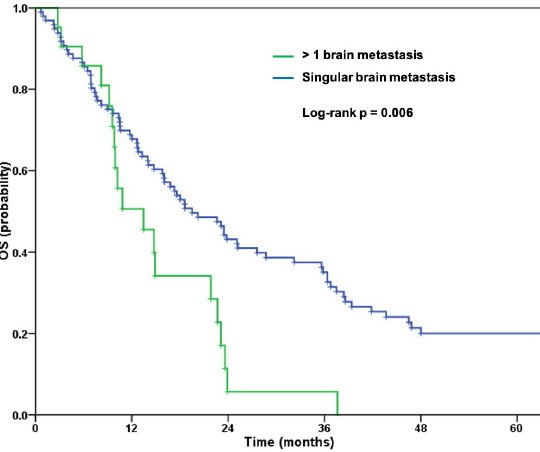
Fig 1. Overall survival for patients with one or more brain